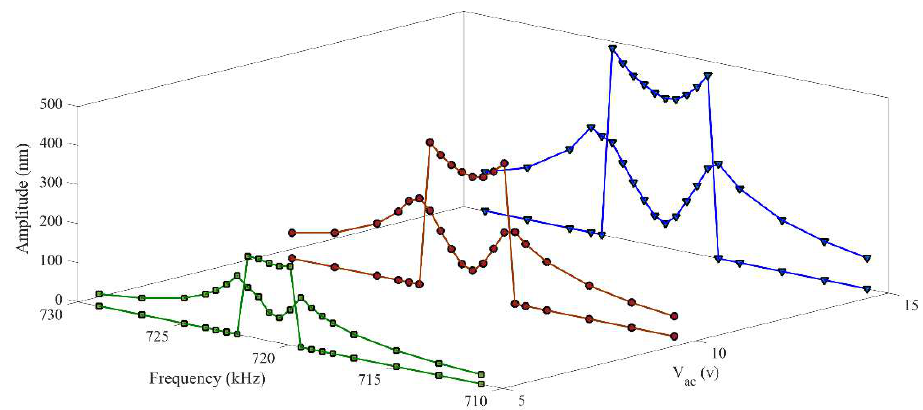
Figure 8. Nonlinear frequency curves in CoventorWare© showing the nonlinear mode coupling between the drive and sense modes.